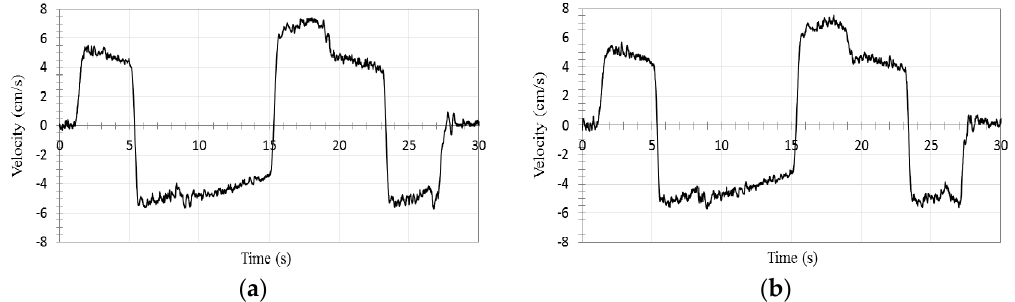
Figure 14. Actuator velocity response to the control signal in Figure 10 at four quadrants of operation for 368 kg mass: ( a ) circuit with only POCVs; ( b ) proposed circuit.